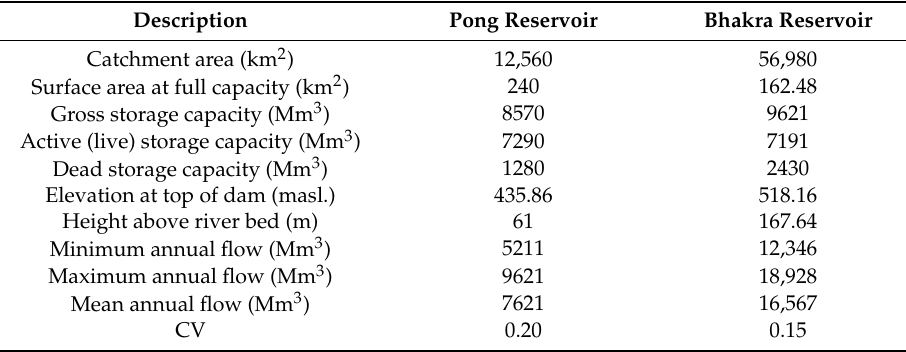
Table 1. Main design characteristics of the Pong and Bhakra reservoirs